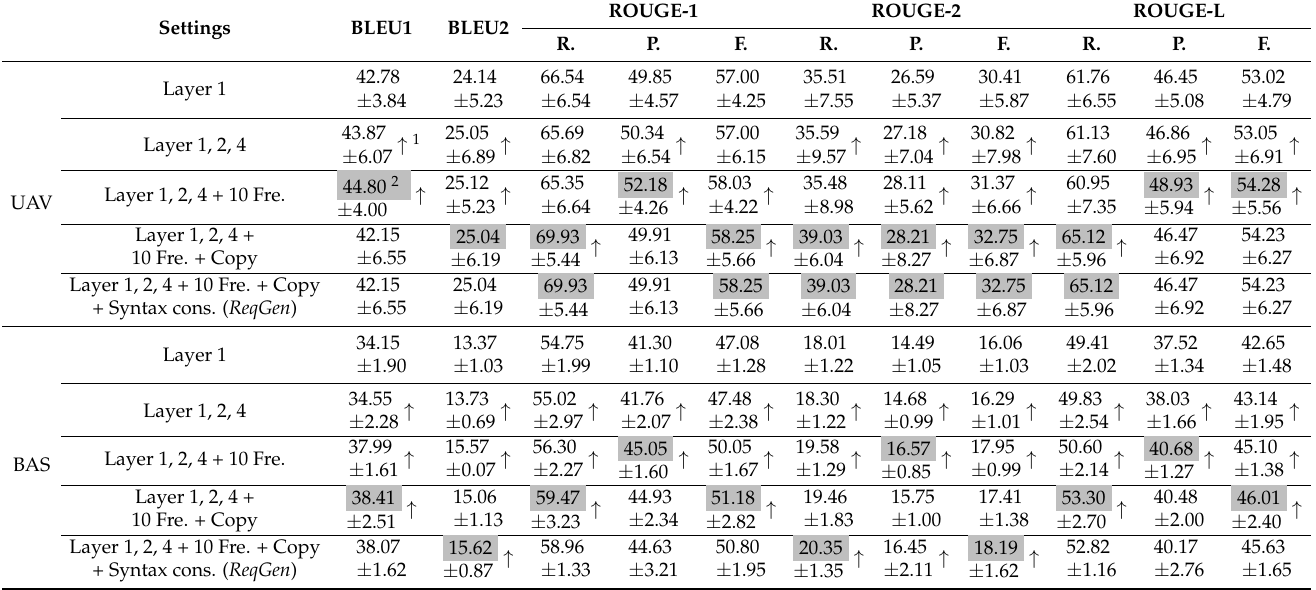
Table 5. The ablation experiment